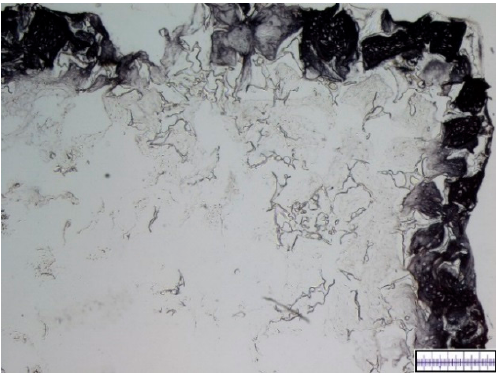
Figure 9. Representative slide of a hyaluronic acid gelatin composite scaffold after 21 days of in vitro chondrogenesis. Collagen type II immunohistochemistry. Collagen type II-rich areas appear black. Magnification bar = 500 μ m.